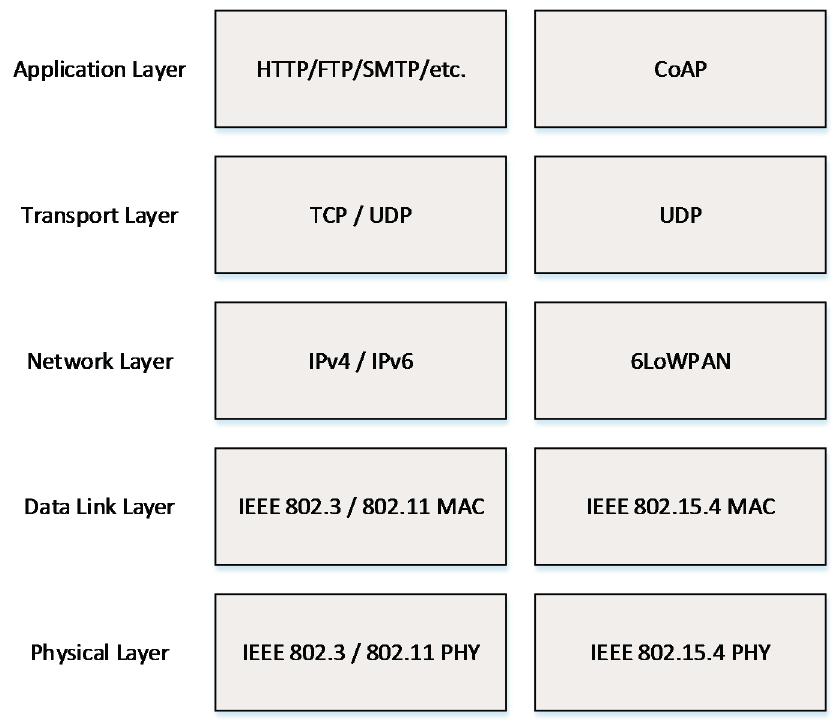
Figure 1. TCP/IP stack and IoT protocol